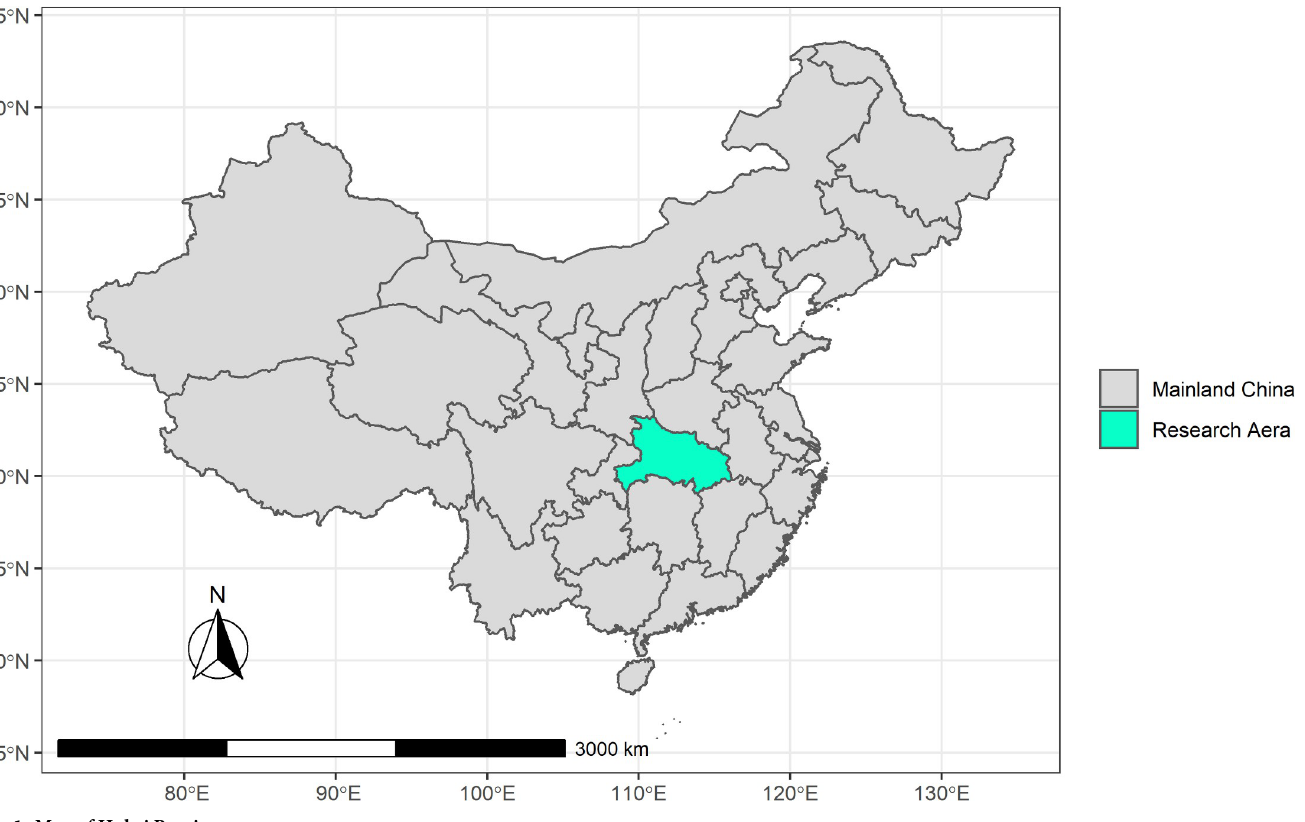
Fig 1. Map of Hubei